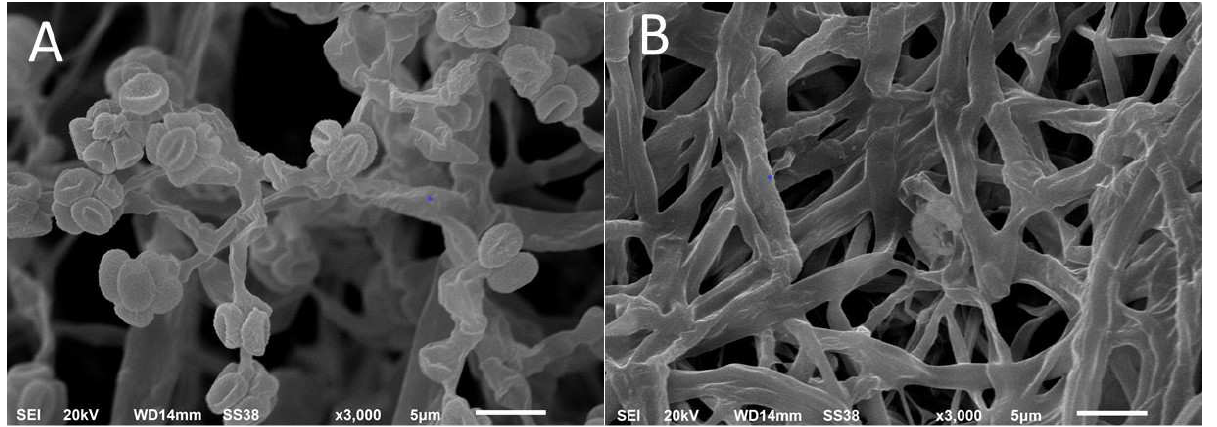
Figure 2. Scanning electron microscopy of the two investigated fungi; ( A ): Trichoderma asperellum ZNW, ( B ): Globisporangium ultimum NZW.